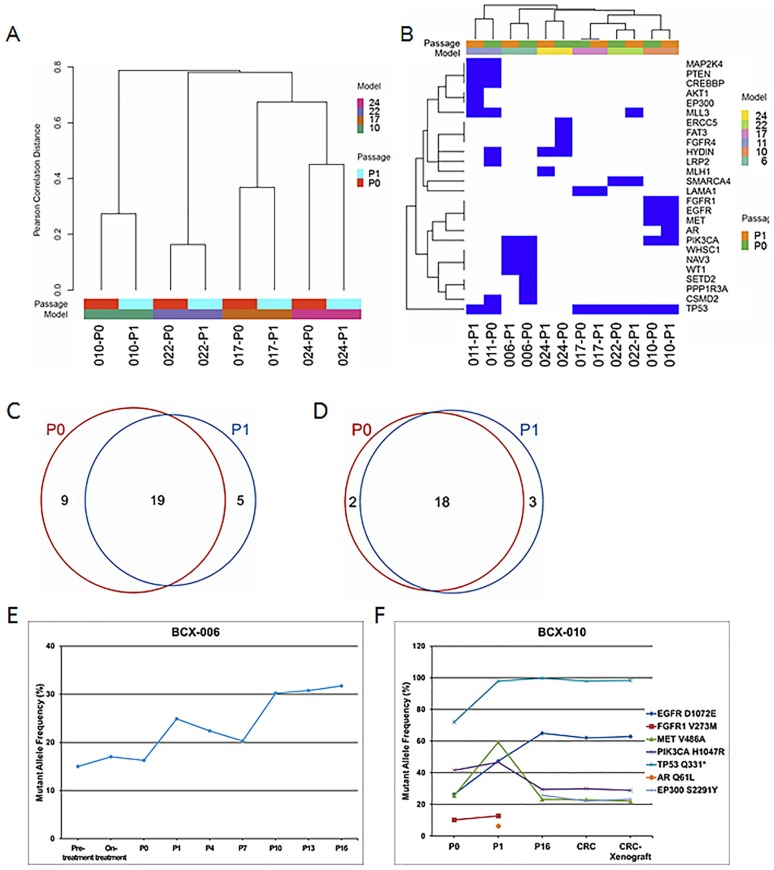
Analysis of mutation data.(A) Clustering of whole exome sequencing mutation data based on the mutation status of the genes in P0 and P1 samples of four models. (B) Clustering of targeted exome sequencing data based on the mutation status of 201 genes in P0 and P1 samples of six models. (C) Venn diagram of mutations in P0 and P1 samples of six models on the targeted exome sequencing platform. (D) Venn diagram of high allelic frequency mutations (10% or higher) on targeted exome sequencing in P0 and P1 samples of six models. Allele frequency cutoff was 10%. (E) Genomic stability of PIK3CA mutation in BCX-006 model. Fine needle aspiration biopsy samples of before and after 12 weeks of neoadjuvant chemotherapy (including a rapalog) were sequenced by ion torrent. Patient’s P0 tumor and BCX-006 P1 tumor and subsequent passages were analyzed by targeted exome sequencing. PIK3CA H1047R allele frequencies are presented. (F) Conditionally reprogrammed cells (CRC) derived from BCX-010 were passaged four times in vitro and then injected into mice flanks. The cultured cells and CRC-derived xenografts maintained a mutation profile similar to the originating PDX.